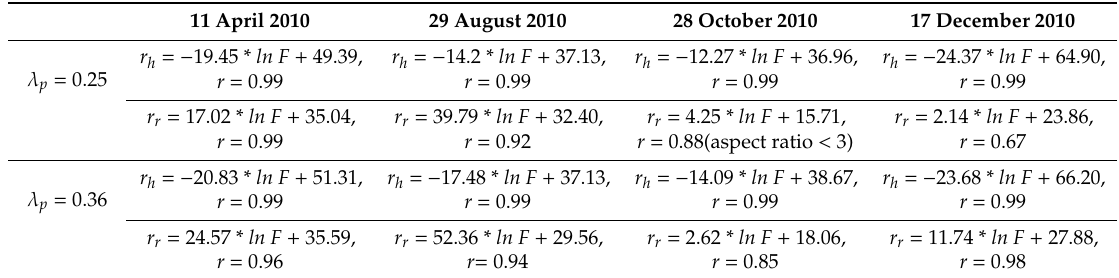
Table A2. Regressions between resistances and F